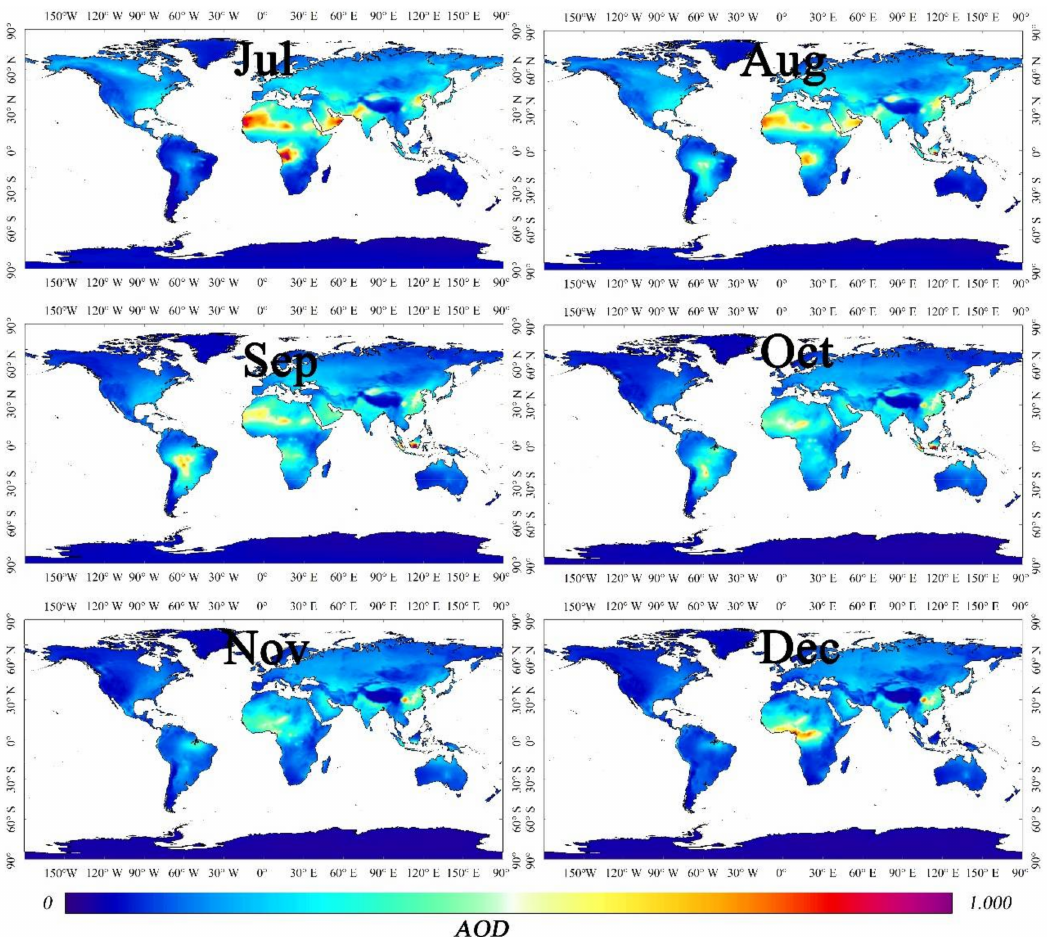
Figure 4. The global spatial and monthly variations of AOD values from July to